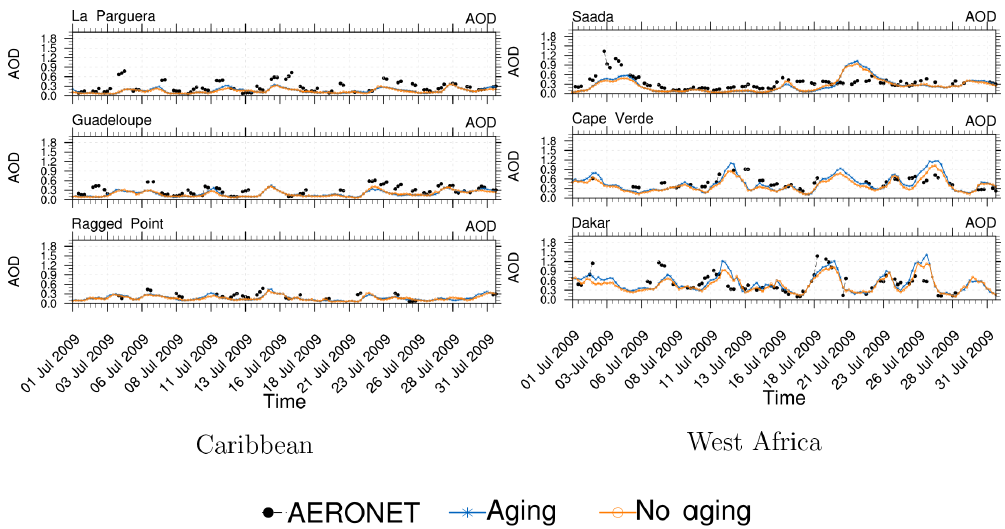
Figure 12. A comparison of the observed (AERONET) and calculated AOD for western Africa and the Caribbean and for two EMAC simulations that include and exclude chemical aging (labeled “aging” and “no aging”, respectively).